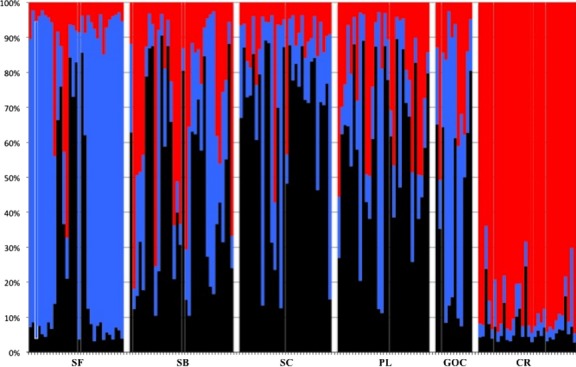
Population assignment of Mustelus henlei as estimated by STRUCTURE. Each individual is represented as a single histogram with percentage of ancestry on the y-axis and populations on the x-axis (SF = San Francisco, SB = Santa Barbara, SC = Santa Catalina, PL = Punta Lobos, GOC = San Felipe, and CR = Costa Rica). Spaces have been inserted between sample localities.